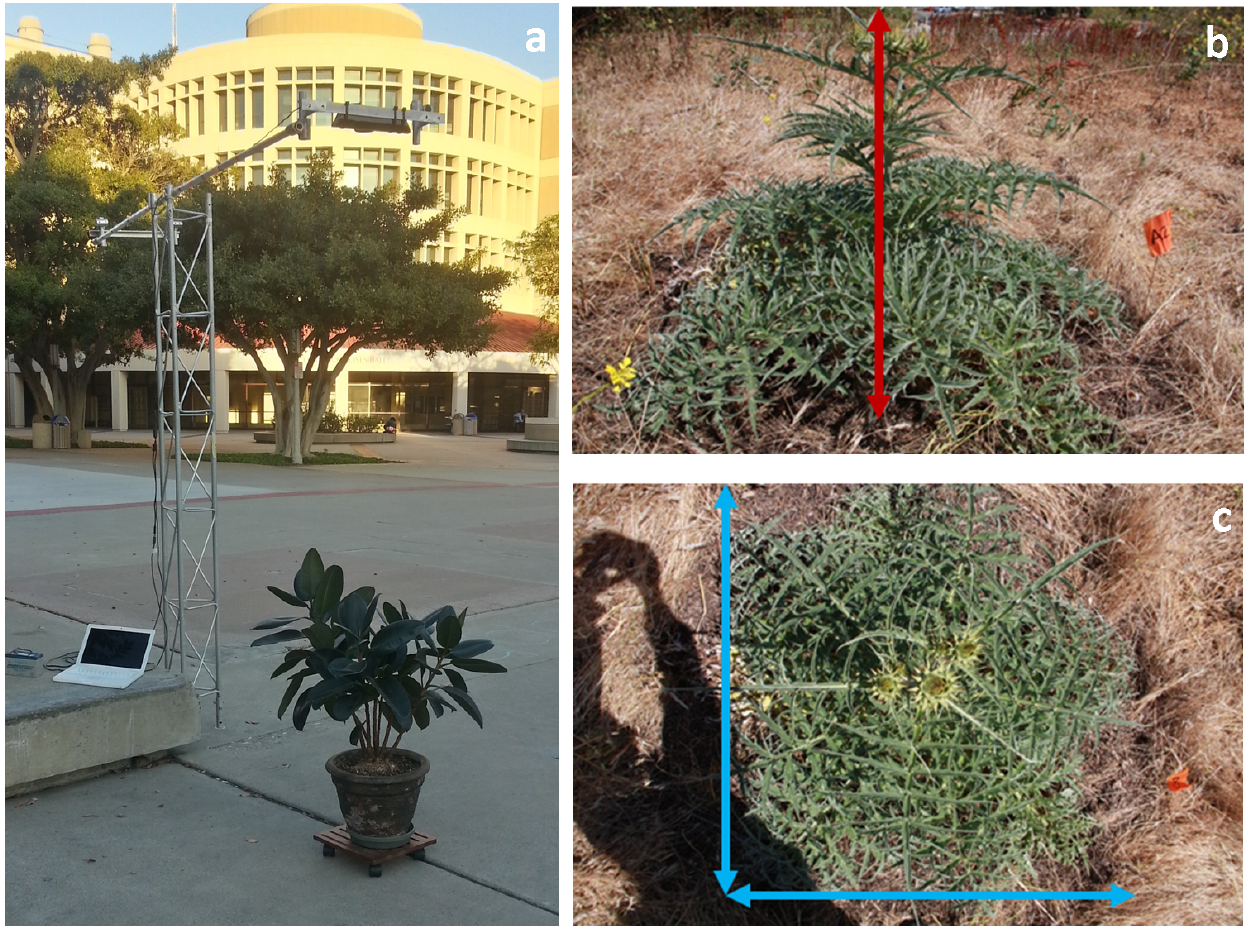
Figure 1. ( a ) The “tower mode” experimental setup used for nadir measurements with Kinect (see Sections 2.3 and 2.4). ( b ) Side view and ( c ) nadir view of a wild artichoke plant recorded during the field test (see Section 2.4). Blue and red lines represent plant’s basal diameter and height as measured manually with a